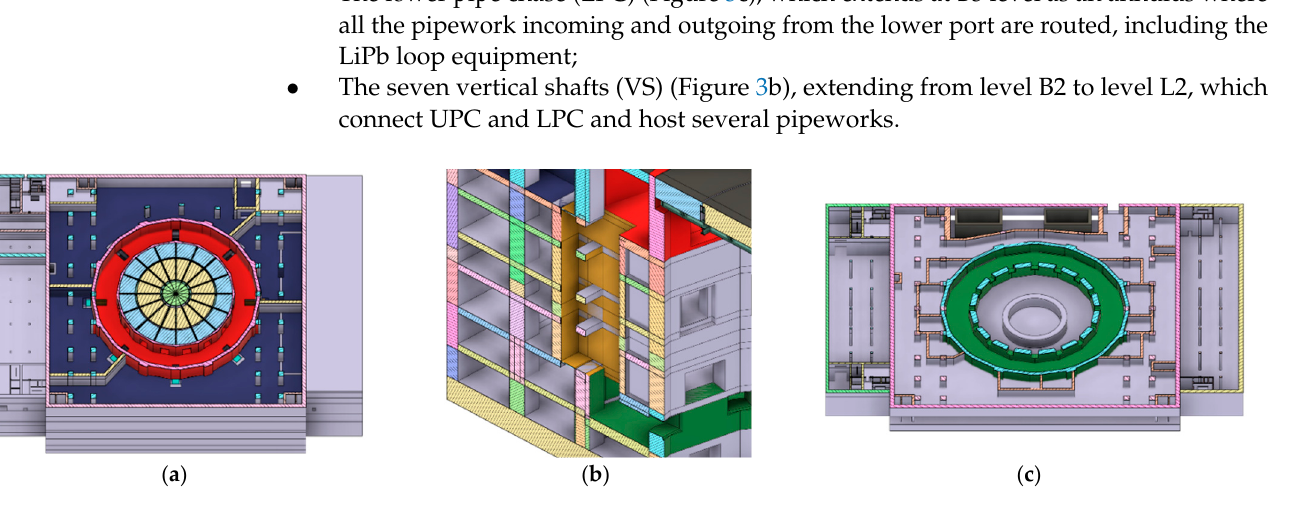
Figure 2. EU DEMO Tokamak Building cross section highlighting free volumes available for steam expansion and building galleries levels.